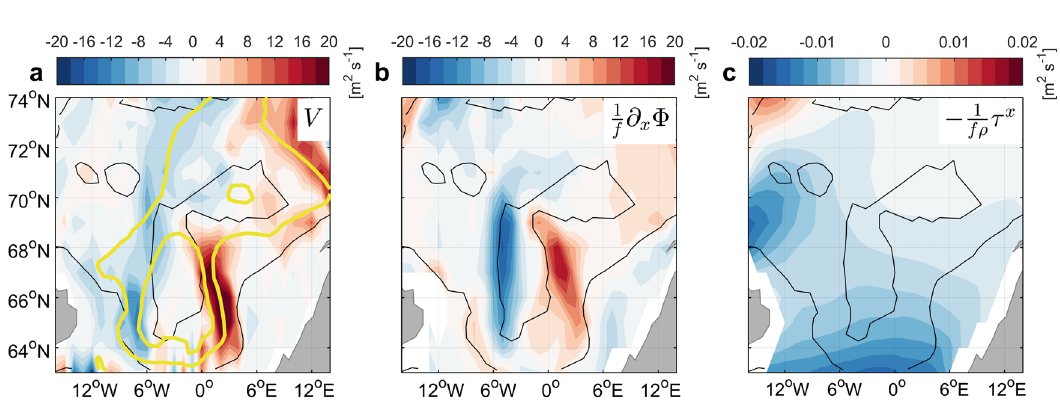
Fig. 4 | Drivers of horizontal circulation changes in the Nordic Seas. a Differences in vertically integrated meridional transport in the eastern Nordic Seas between 2071 – 2080 and 2031 – 2040 (m 2 s − 1 ) in CESM-LE. Positive (negative) values on the eastern (western) side of the domain indicate strengthened cyclonic